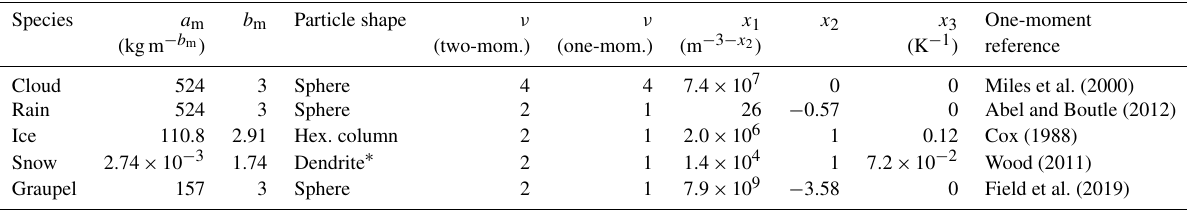
Table A1. Summary of microphysical parameterizations for liquid- and ice-phase hydrometeors.